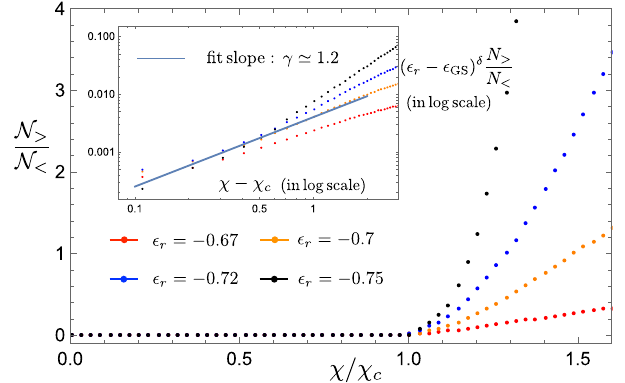
Fig. 4 | States ratio and scaling exponents. Ratio of higher- and lower-energy isolatedlocalminimaintersectingwiththereferencestateasafunctionoftheslope χ / χ c . The data is taken for several values of the reference state energy ϵ r . The ground-stateenergyis ϵ GS = − 0.8.Theinsetshows ð ϵ r (cid:2) ϵ GS Þ δ N > = N < vs. χ − χ c inlog- log scale; solid line is fi tting with Eq.